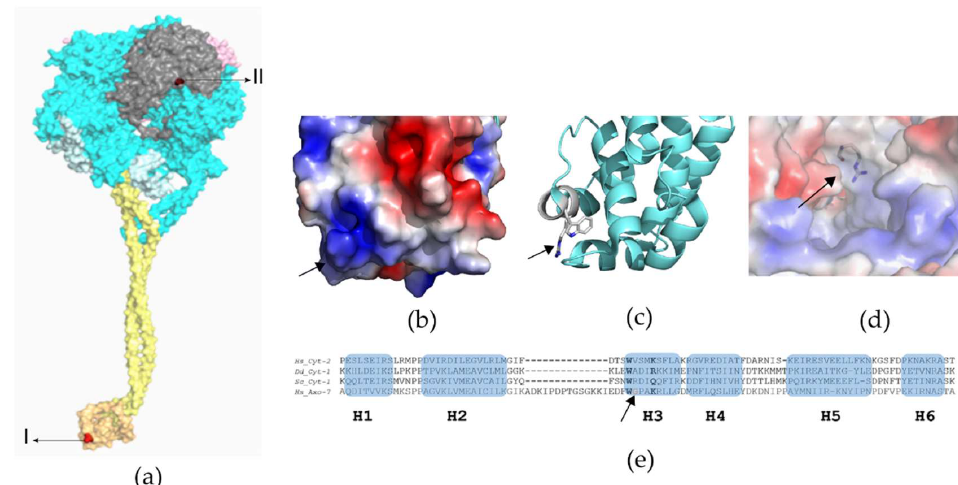
Figure 3. Structural analysis of DNAH7 variants. ( a ) General dynein motor domain structure: N-terminal linker (pink), six AAA domains in ring arrangement (blue), stalk (yellow) containing the MTBS (orange), C-terminal (grey). Mutations (red) p.Gly2737Ser (I) and p.Arg3983trp (II). Crystallographic model PDB